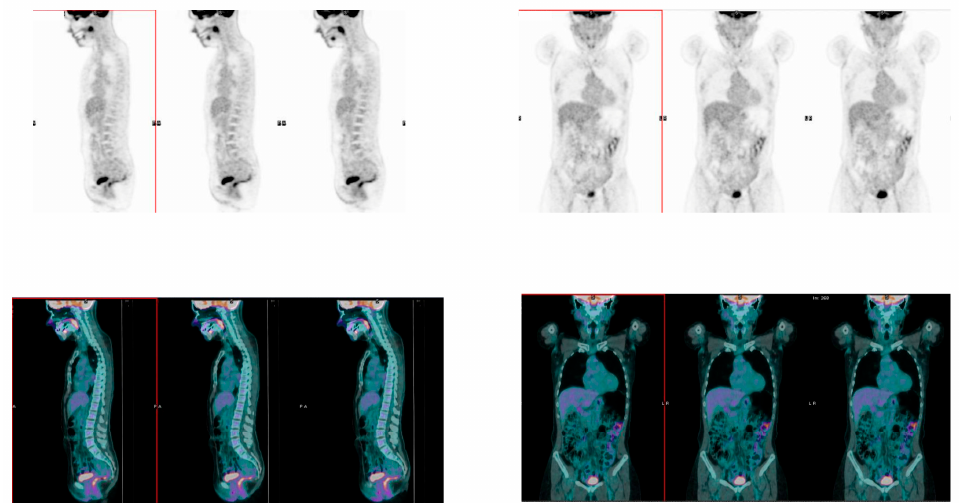
Figure 2. Sagittal (left panel) and coronal (right panel) images of whole-body [18]F-FDG PET/CT scan. PET (upper panels) and fused PET/CT (lower panels) images, showing faint diffuse [18]F-FDG colon and rectum uptake in a BC patient who reached pCR. FDG, fluorodeoxyglucose; PET/CT, positron emission tomography/computed tomography; BC, breast cancer; pCR, pathological Complete Response; PA: posterior-anterior, ; LR: left-right.